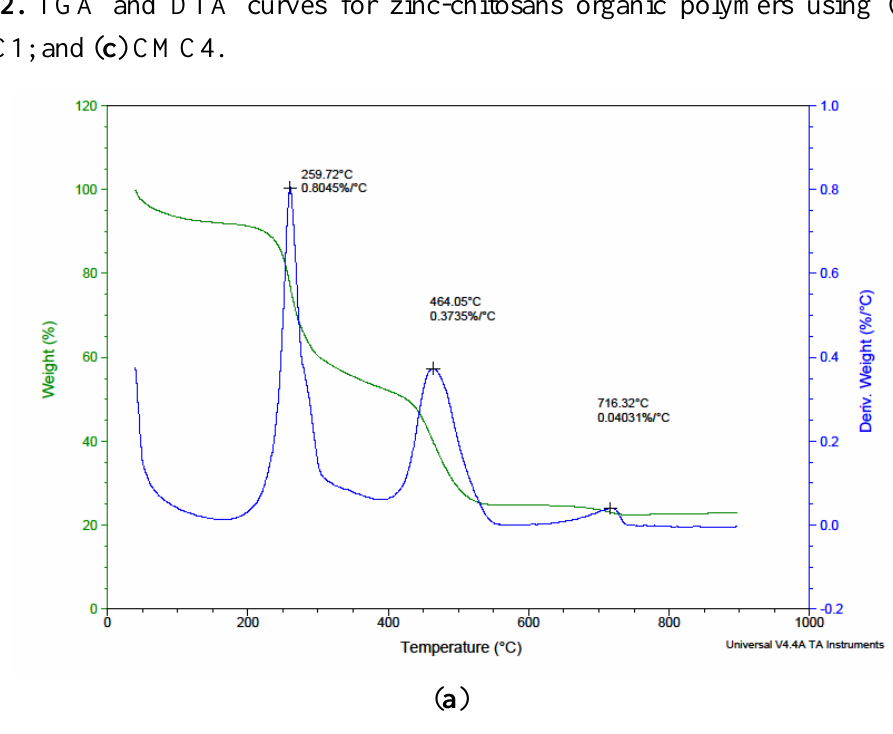
Figure 2. TGA and DTA curves for zinc-chitosans organic polymers using ( a ) CTS; ( b ) CMC1; and ( c ) CMC4.